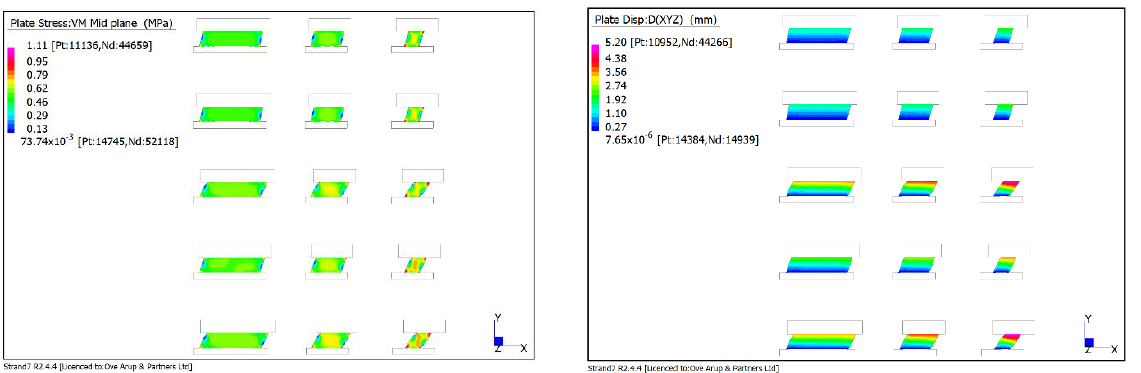
Fig. 16 Silicone analysis – shear load, left -VM plate stress, right- horizontal deformations.